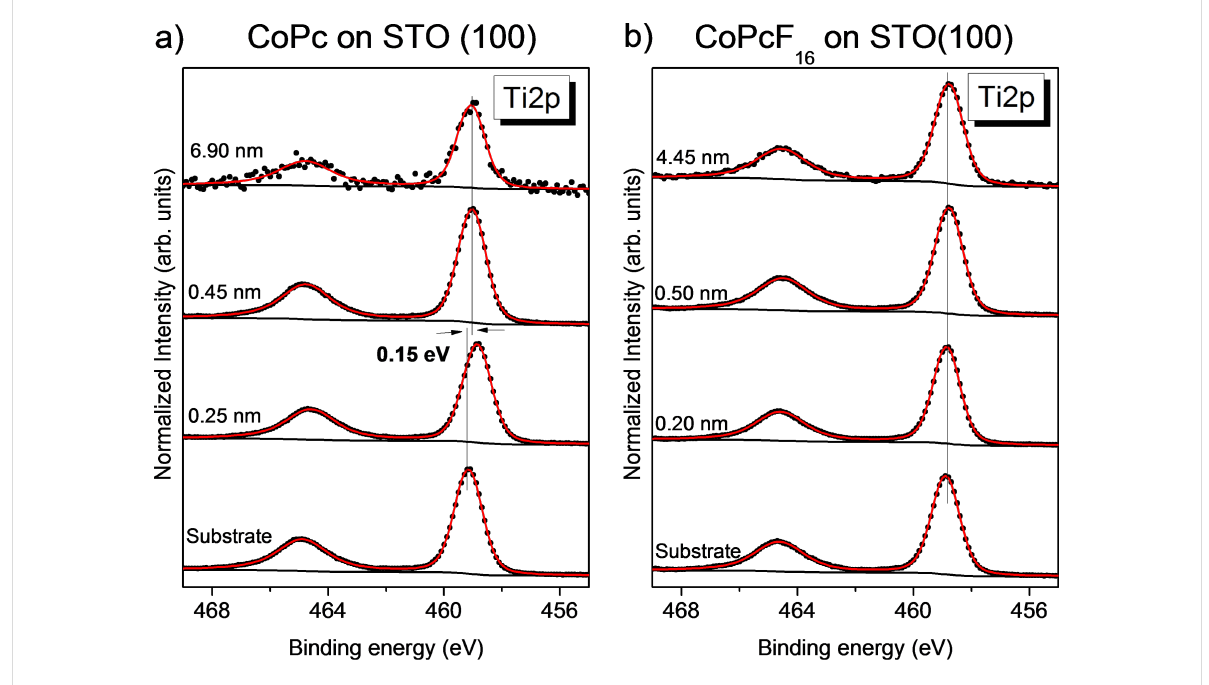
Figure 2: Development of Ti 2p spectra as an example for the change of substrate-related core level spectra with increasing thickness of (a) the CoPc or (b) the CoPcF 16 films.